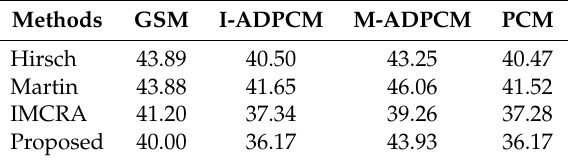
Table 2. The average LSD (in dB) of the actual noise and estimated noise of our method and other noise estimators for various communication channels. I, IMA; IMCRA, improved minimum controlled recursive